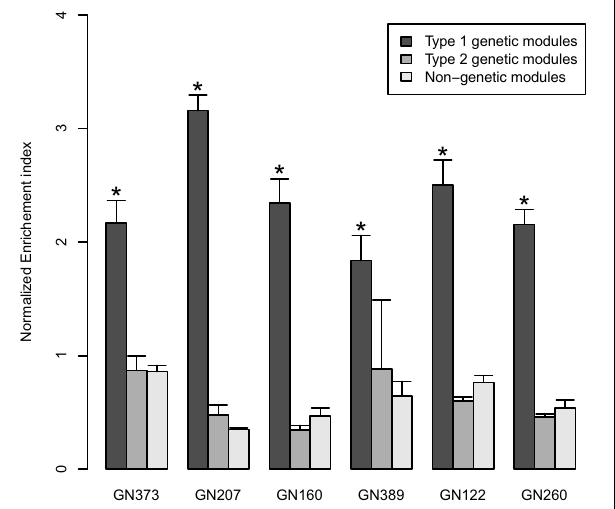
FIGURE 1 | The bar graphs represent normalized enrichment indices (mean ± SD) in the 6 tested discovery datasets. The indices quantify to which extent genes in co-expression network originate from a single chromosome. Black bars: values for “genetically-driven” modules (type 1 genetic modules); gray bars: values for the other “genetic” modules (type 2); white bars: values for “non-genetic modules.” ∗ P < 0 . 05 (Kruskal Wallis